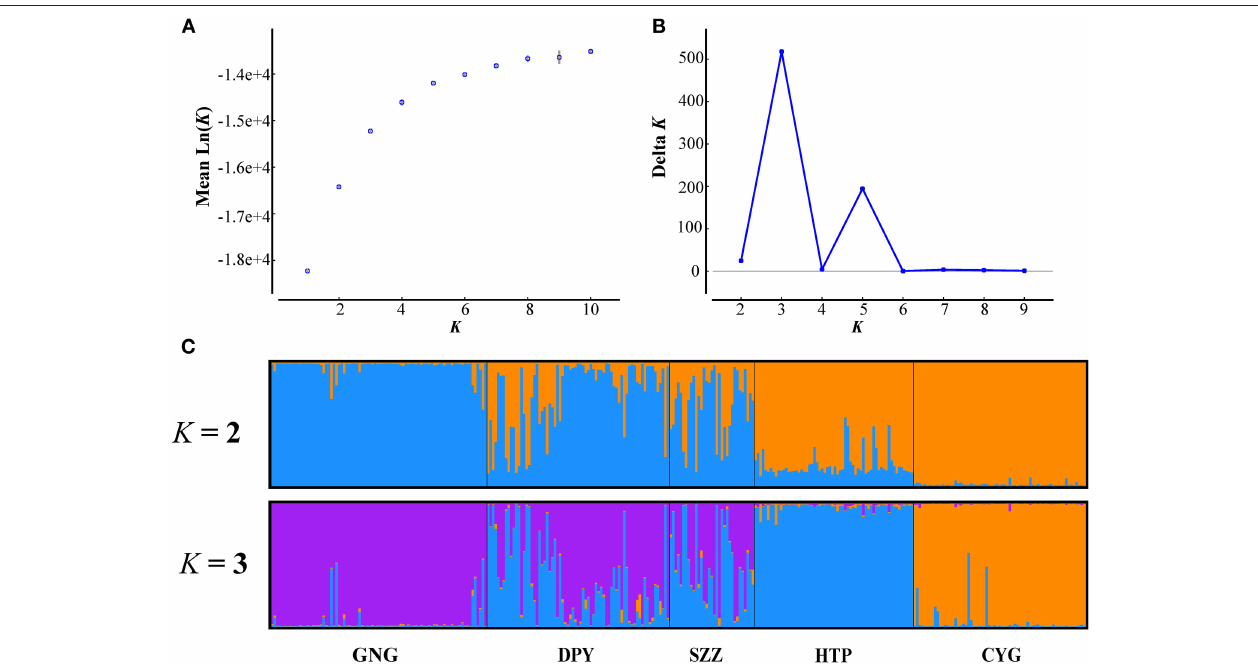
FIGURE 2 | Structure analyses using the LOCPRIOR model. (A,B) The mean estimated L ( K ) and 1 K as a function of number of clusters ( K ). (C) The bar plots for K = 2 and